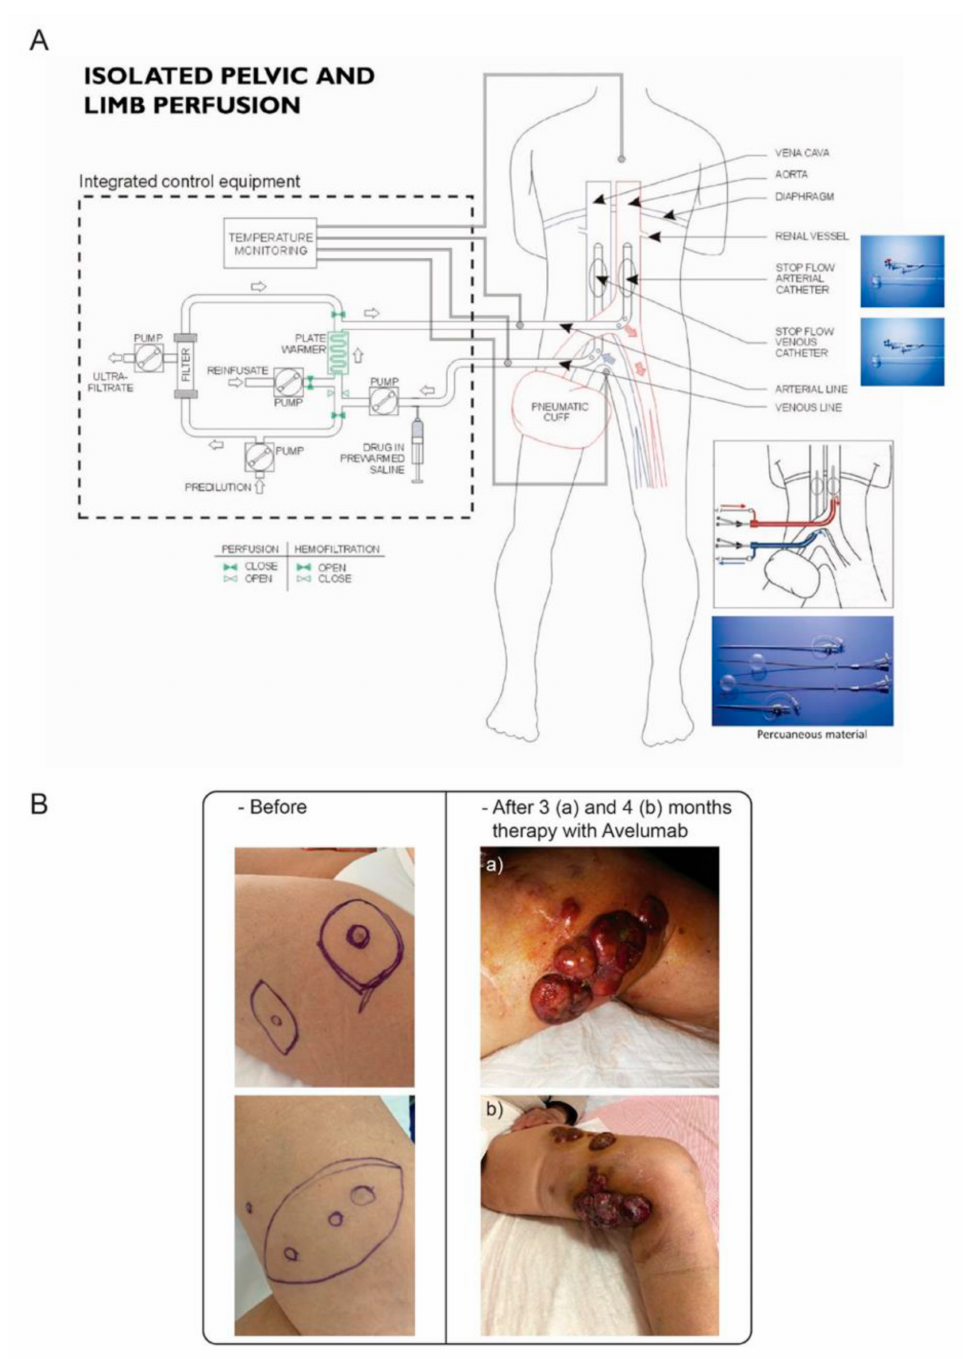
Figure 2. ( A ) Schematic representation of isolated pelvic and limb perfusion with extracorporeal blood circulation controlled by an integrated equipment circuit, complete with chemofiltration unit and apparatus used for open and percutaneous approaches (cartouche). ( B ) Response to avelumab therapy: MCC tumours prior to avelumab therapy (left panels) and following (a) 3 months and (b) 4 months of avelumab therapy (right